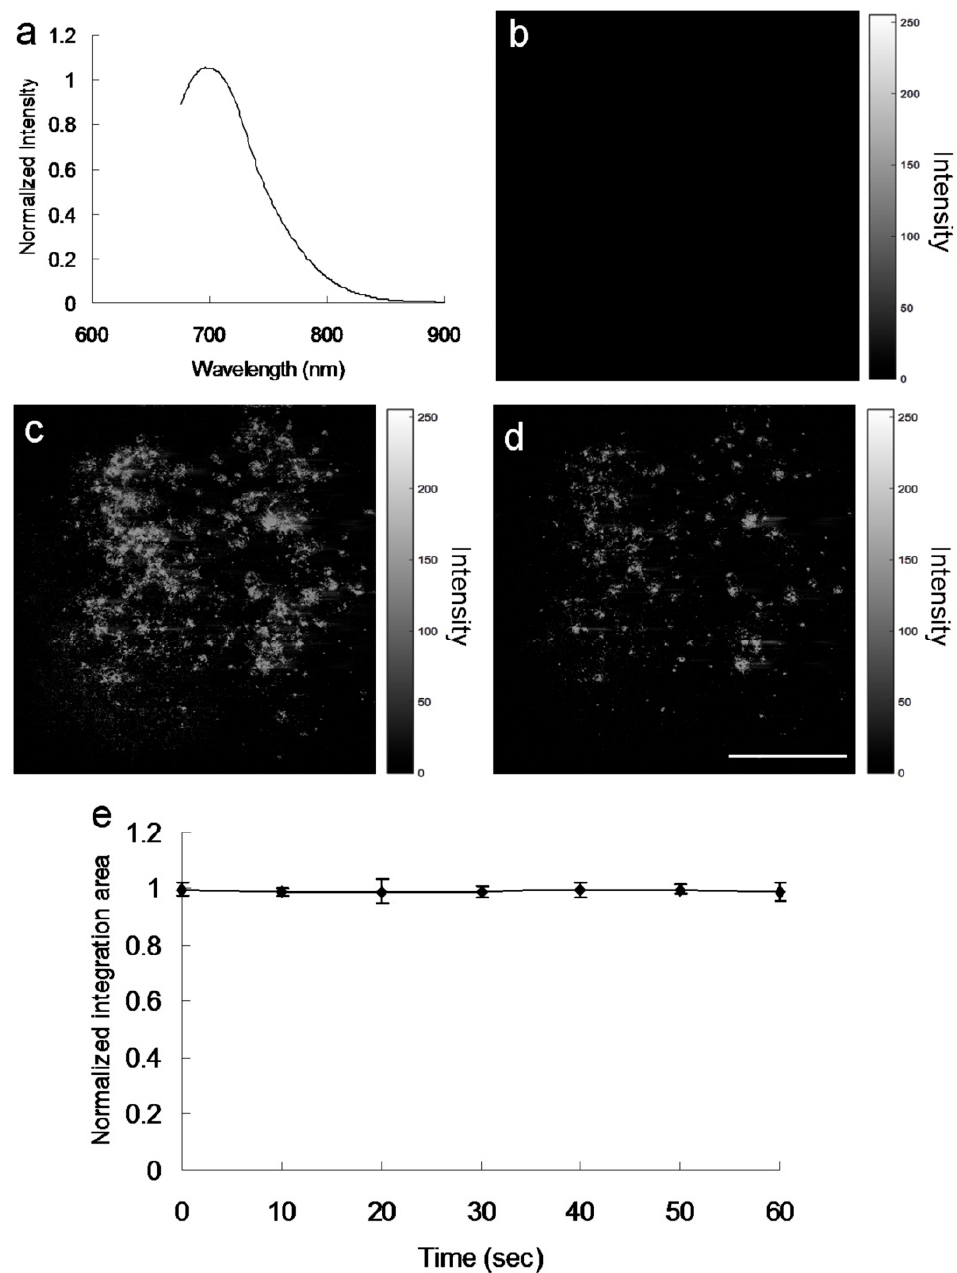
Figure 7. ( a ) Relative PL spectra of amino-N-GQDs exposed to one-photon excitation (Ex/Em: 670/696 nm). Gray-level luminescence images of ( b ) untreated MRSA and ( c , d ) amino-N-GQD–Ab protein A -treated MRSA and material-treated bacteria after photoexcitation for 60 s (0.07 W cm − 2 ; Ex: 670 nm), respectively. On 3 h of additional incubation, the PDT action would be effectively processed. ( e ) Photostability assessment results. For emission wavelengths of 675–900 nm and as a function of exposure time (0 − 60 s), the relative intensity of the integrated area is almost constant, indicating high photostability. Delivered dose: OD 600 = ~0.05 µ g · mL − 1 for bacteria and 0.5 µ g · mL − 1 for material–Ab protein A . Scale bar: 50 µ m.